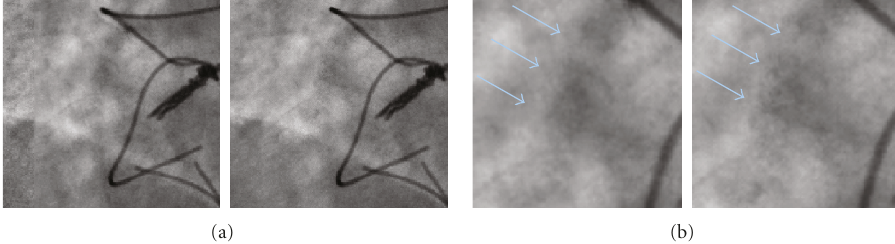
Figure 14: (a) Fluoroscopic sequence processed with the HR, and (b) the ANMCR filter. The two images on the right correspond to a zoom on the region of interest of the two images of (a)